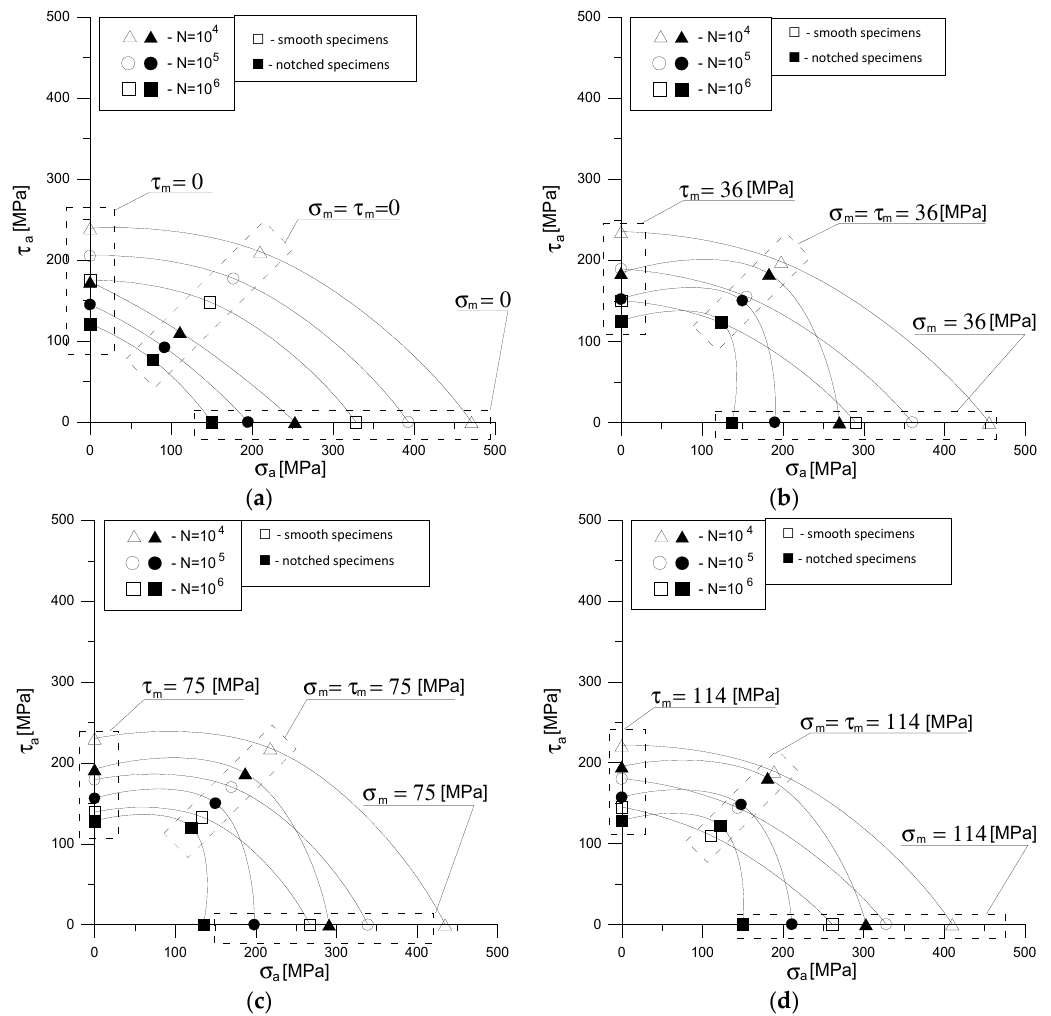
Figure 6. Graphs of bending and torsion stress of smooth and notched specimens for various fatigue life and ( a ) σ m = τ m = 0, ( b ) σ m = τ m = 36, ( c ) σ m = τ m = 75, ( d ) σ m = τ m = 114 MPa